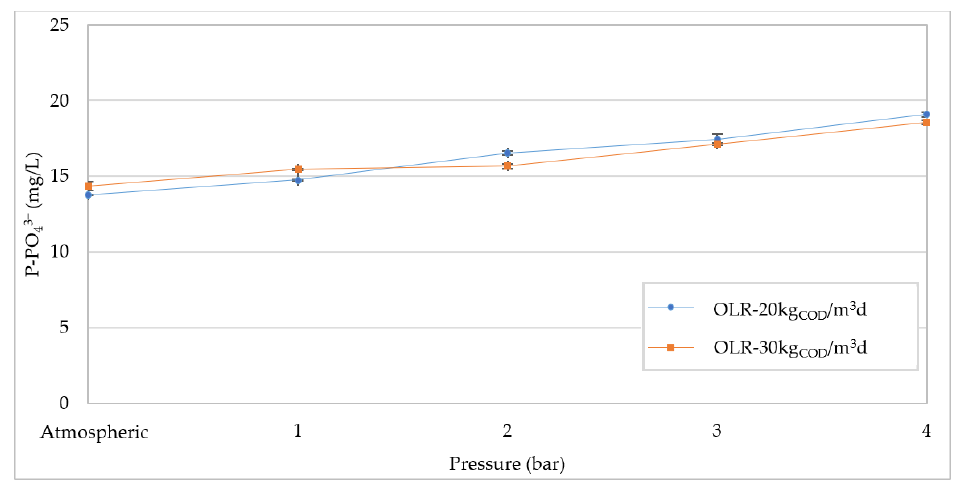
Figure 13. Phosphate (P-PO 43 − ) concentration at increasing pressures for organic load rate (OLR) of 20 kg COD /m 3 d and 30 kg COD /m 3 d . 20 kg 3 d and 30 kg 3 COD /m COD /m